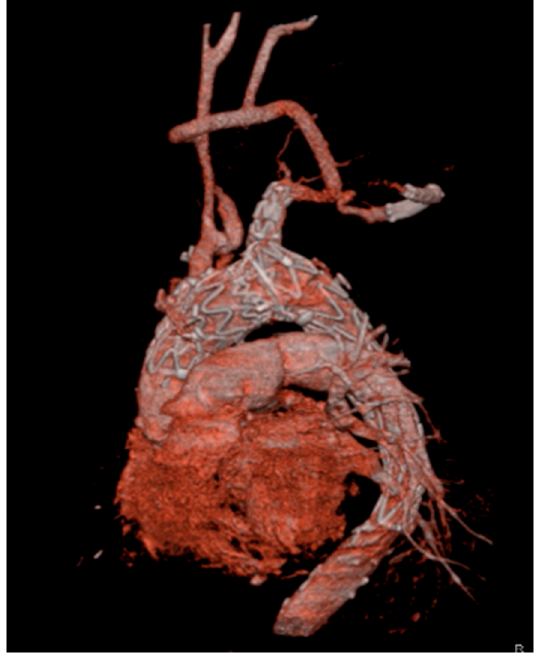
Figure 2. Three-dimensional reconstruction of a Nexus device with the side-branch positioned in the left subclavian artery. Patent and well-functioning supra-aortic debranching is clearly